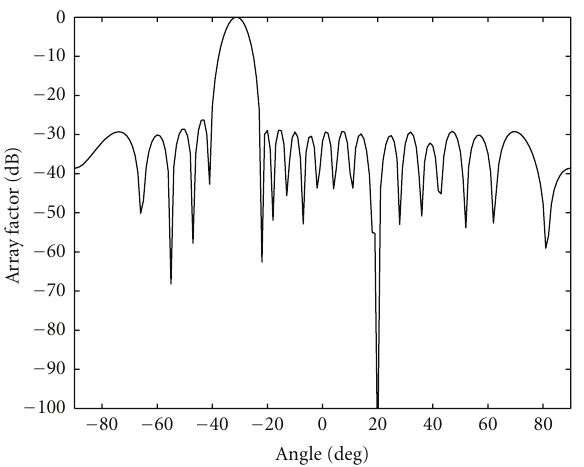
Figure 5: Radiation pattern of the 20 element linear array with null at 20 ◦ , main beam at − 30 ◦ and SLL at − 30 dB.